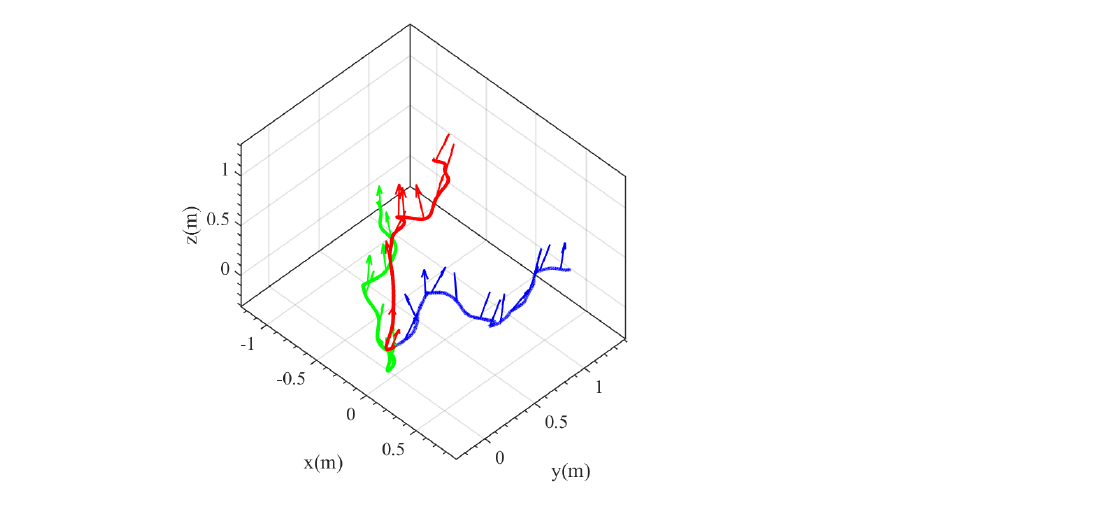
Figure 21. Three trajectories of the prototype in flight test. The line indicates the position and the arrow indicates the attitude.